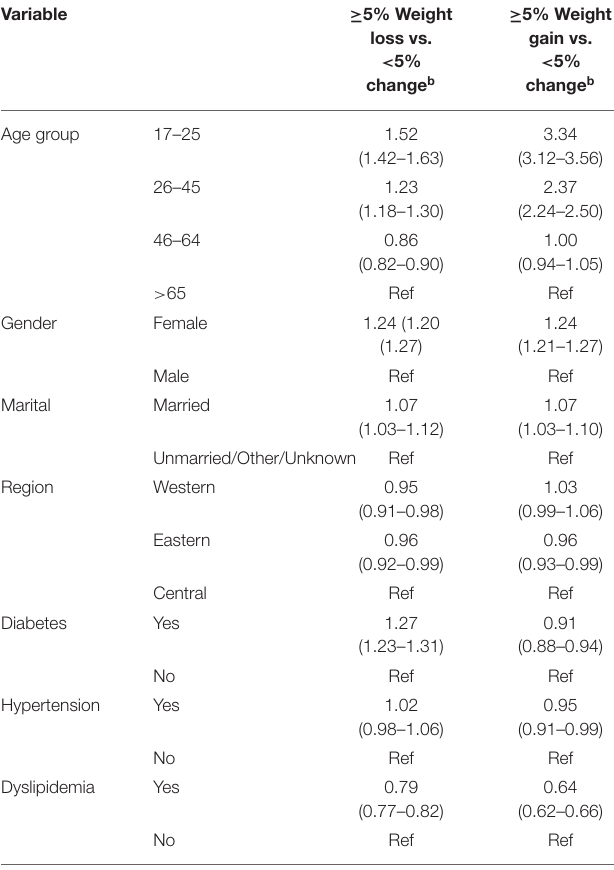
TABLE 3 | Multinomial logistic regression of predictors of 5% weight change among the study population a . Variable ≥ 5% Weight